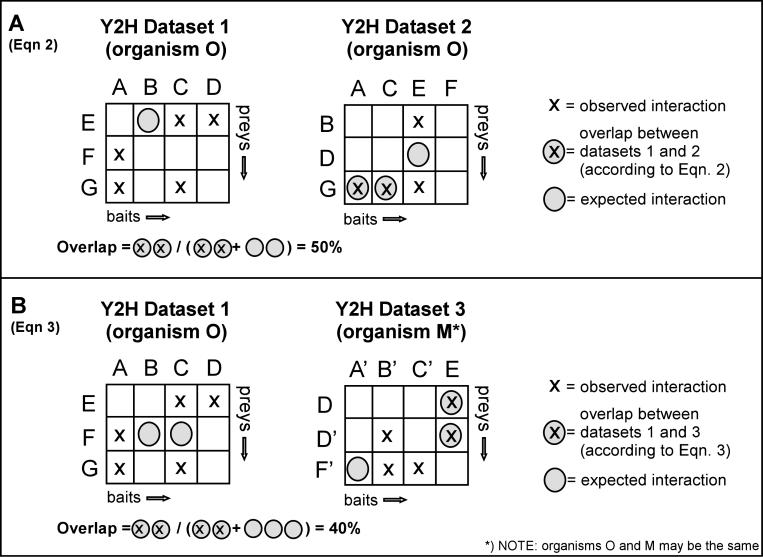
Ways of Calculating the Overlap between Two Y2H Datasets(A) Identity-based overlap between Datasets 1 and 2 according to Equation 2. Note that we can only calculate this score if both datasets are from the same organism. Starting with the observed interaction C-E in Dataset 1, we are trying to find the exact same interaction in Dataset 2. The following situations might occur: (a) C and E are also observed to interact in Dataset 2. (b) C and E are not observed to interact in Dataset 2. (c) It is impossible for C and E to be interacting in Dataset 2 due to either of these two reasons: (i) Either C or E are not part of Dataset 2 or (ii) C and E are either both used as preys or both used as baits in Dataset 2. Repeating the above procedure for all other observed interactions in Datasets 1 and 2, we finally calculate the identity-based overlap by dividing the number of common interactions found in Datasets 1 and 2 by the total number of expected interactions (observed and not-observed).(B) The same procedure as described above is applied to the two Datasets 1 and 3, which are now allowed to be from different organisms. The only difference to Equation 2 (A) is the usage of homology for comparing two PPIs instead of a binary decision scheme (PPIs identical or not-identical). Thus, starting with the interaction D-E from Dataset 1, we try to find possible homologous interactions (not only the identical PPI) in Dataset 3. The only two options in this example are D-E and D′-E (Dataset 3), which in our example are both observed in Dataset 3. Iterating through all observed interactions of Datasets 1 and 3 and summing up the expected interactions and the overlapping homologous interactions, we can then calculate the homology-based overlap (Equation 3). Note that any results from Equation 2 are not comparable to any results from Equation 3.